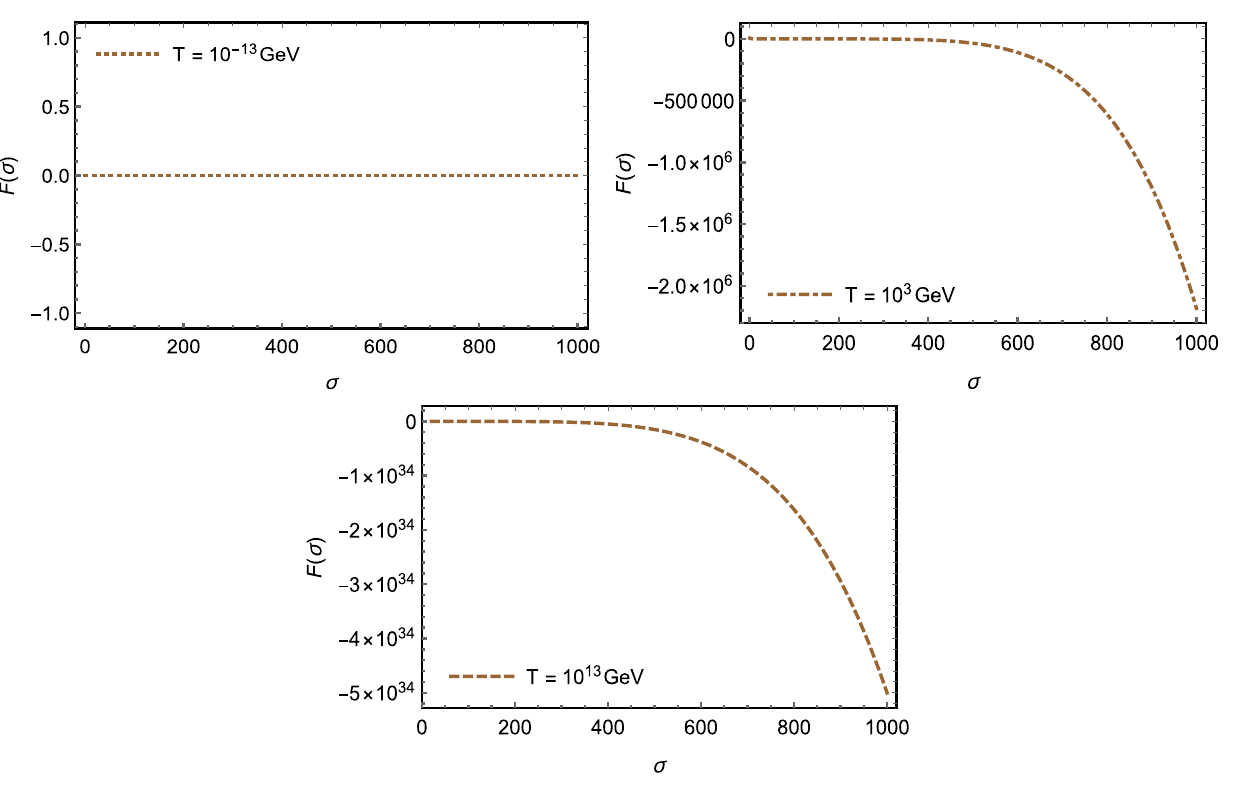
Their behaviors are shown in Figs. 5, 6, and 7